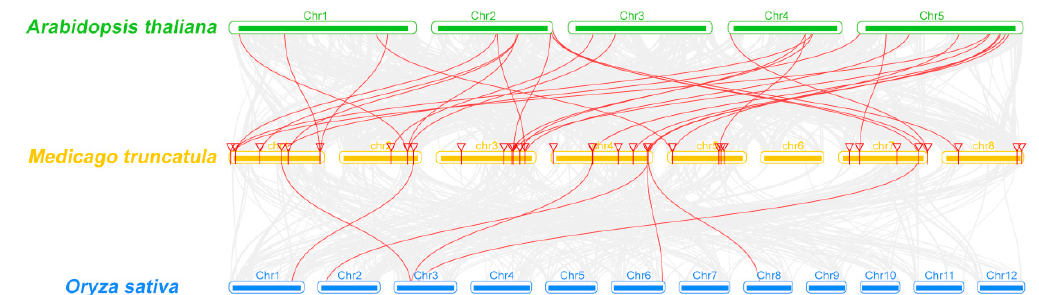
Figure 2. Synteny analyses of MtCCT genes between M. truncatula and A. thaliana / O. sativa . Gray lines in the background indicate the collinear blocks within M. truncatula , and A. thaliana / O. sativa , and the red lines highlight the syntenic MtCCT gene pairs.